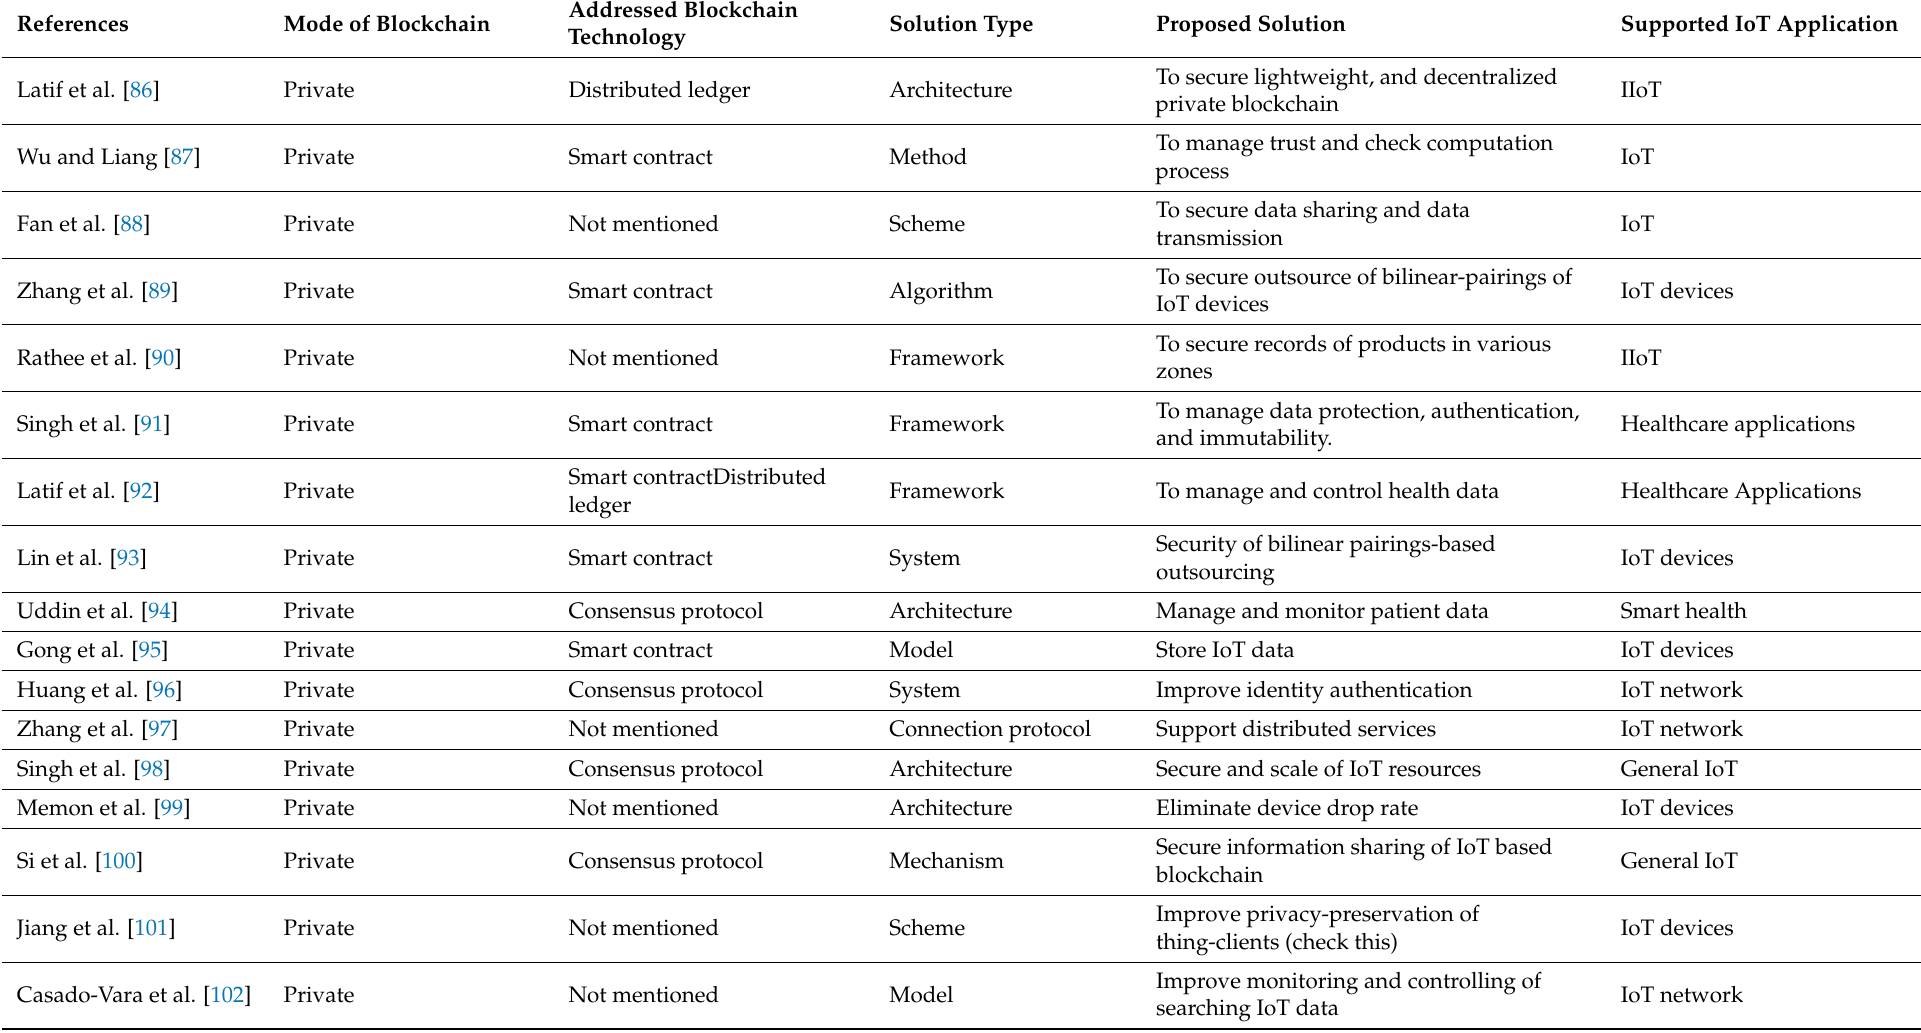
Table 5. Recent advances in Blockchain for IoT